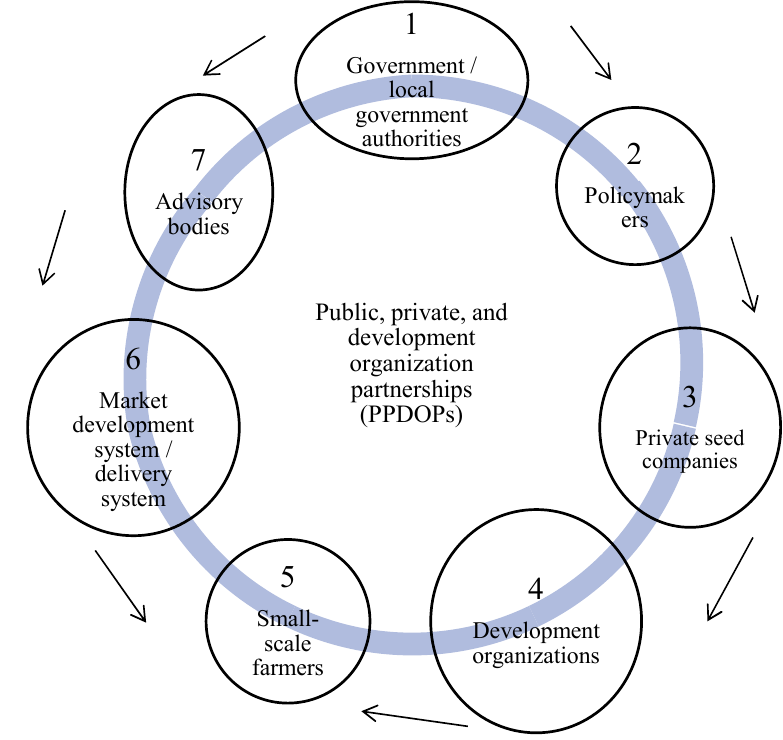
Figure 2. Conceptual framework.